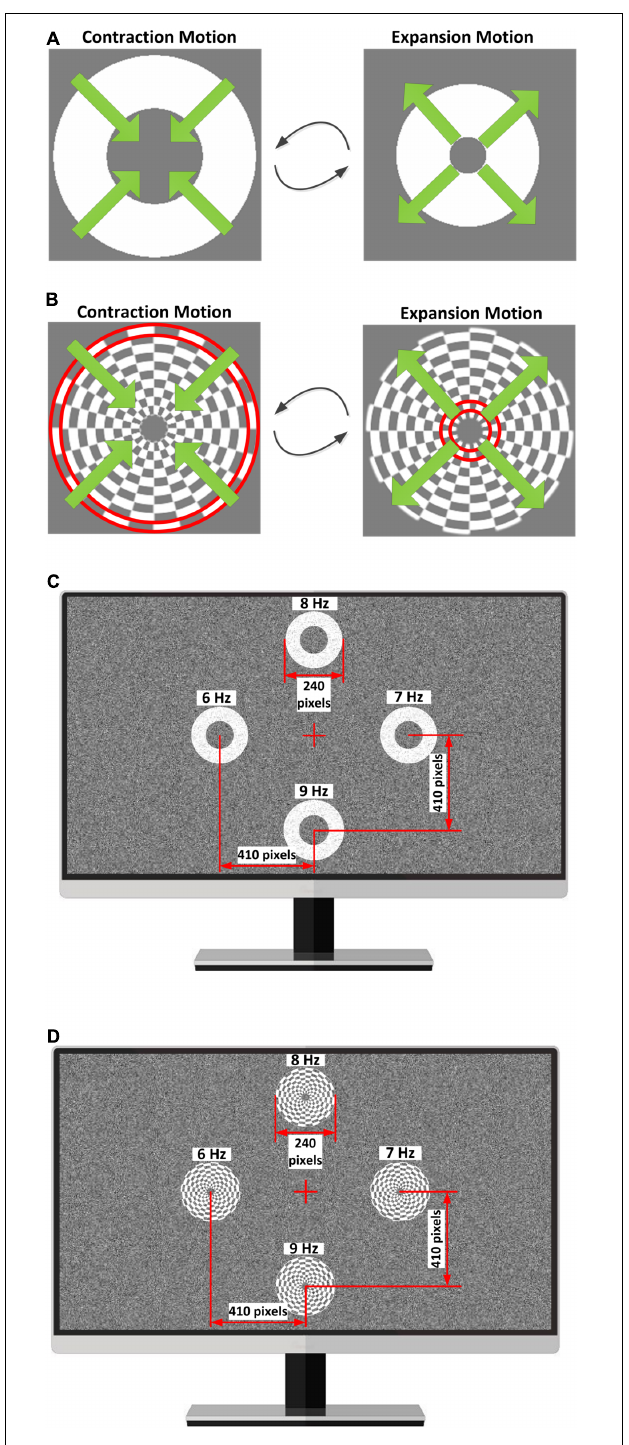
FIGURE 2 | Stimulus paradigms used in this study. (A) Contraction-expansion procedure of the motion-reversing single ring under an NSD value of 0. (B) Contraction-expansion procedure of the motion-reversing checkerboard under an NSD value of 0. The red boundary line shows a single ring on the checkerboard. (C) Distribution of four simple ring stimulators on the screen under an NSD value of 24. (D) Distribution of four complex checkerboard stimulators on the screen under an NSD value of 24. FIGURE 3 | Experimental